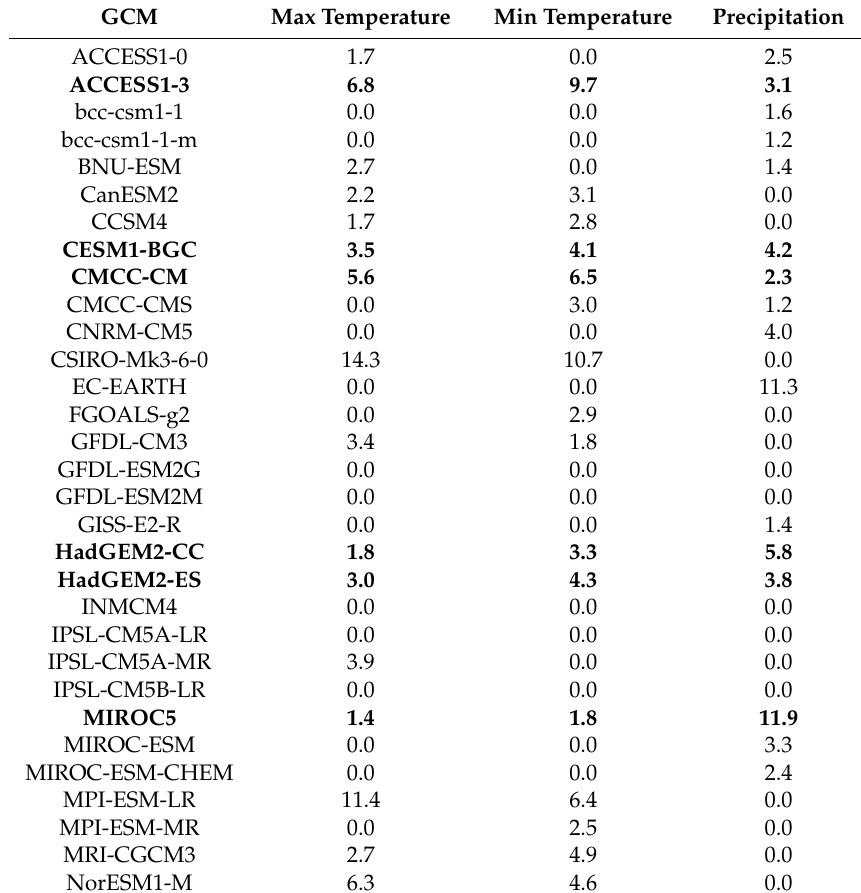
Table 5. The GCMs received the highest scores in replicating temperature and precipitation at all the grid points over Pakistan. The selected GCMs are shown in bold